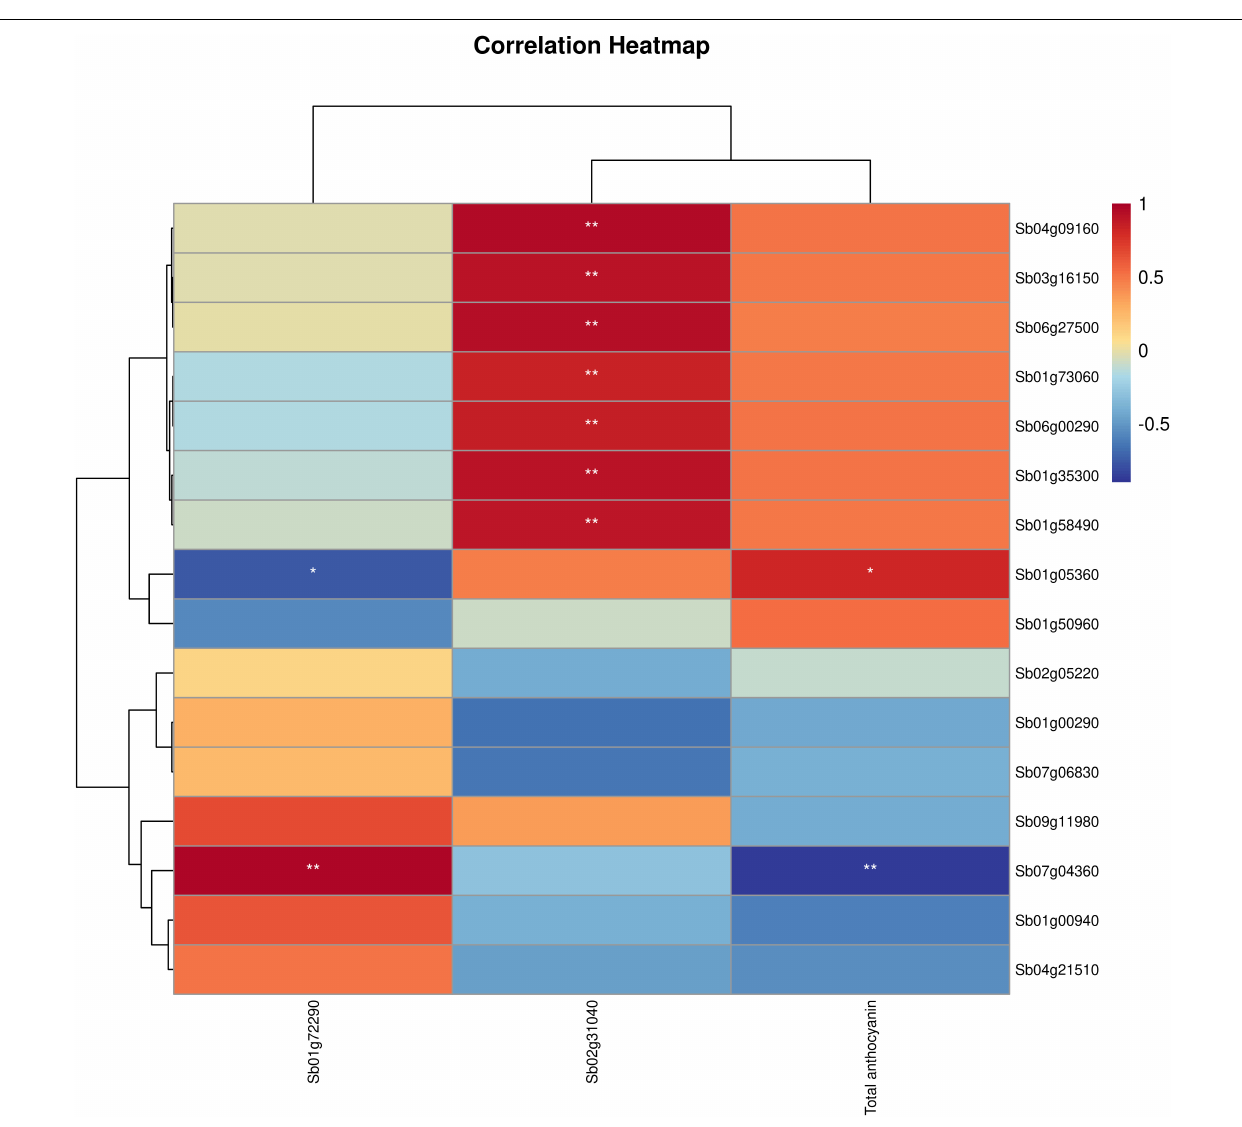
FIGURE 6 | Correlation heatmap of TFs with total anthocyanins and key genes. The color scale on the right represents the degree of correlation among TFs, genes and anthocyanins. The red represents high correlation degree and blue represents low correlation degree. One asterisk represents correlation and two asterisks represent significant